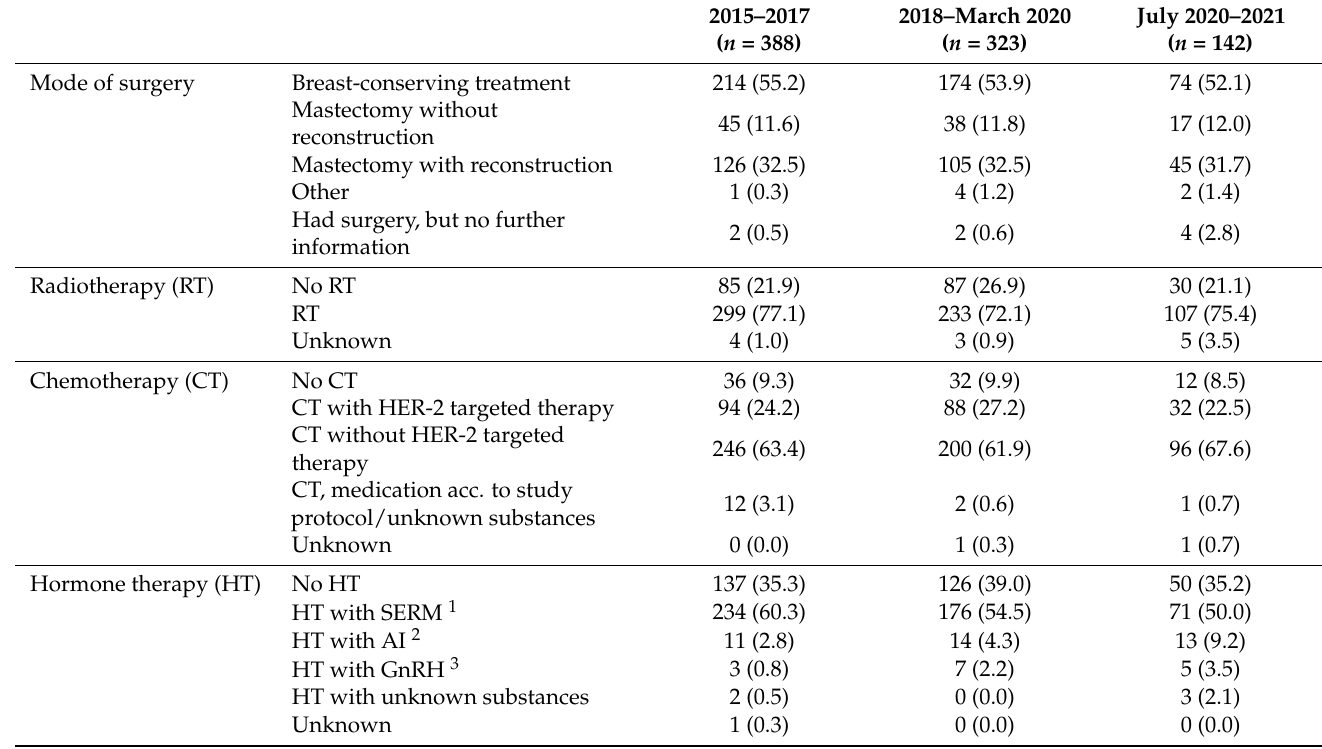
Table 3. Treatment of young adult non-metastatic breast cancer patients with minor children partici- pating in a 3-week inpatient mother–child rehab program according to time of rehab